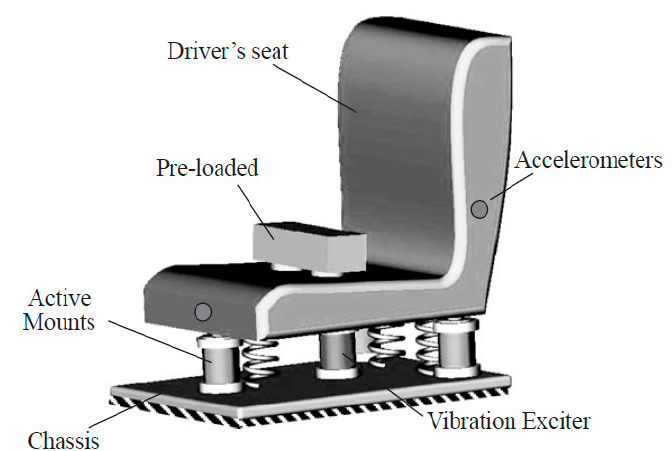
Figure 11. Structure of active seating system [71]. Appl. Sci. 2020 , 10 , x FOR PEER REVIEW